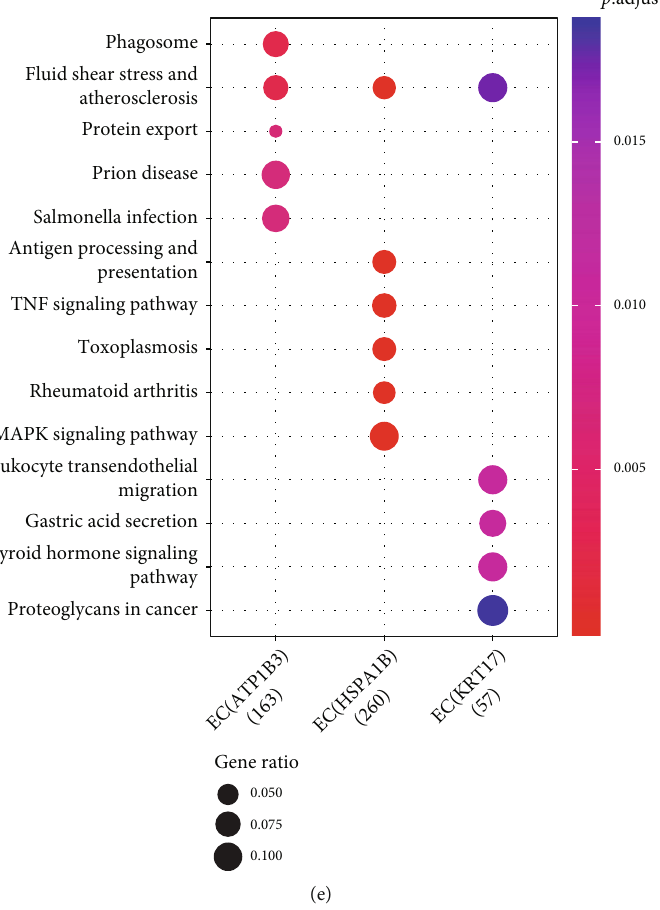
Figure 2: scRNA-seq analysis showed three subclusters in breast-associated biopsies. (a) UMAP plot showed integration of endothelial cells isolated from normal breast and TNBC tissues. Three subclusters were identi fi ed based on genetic pro fi les. (b) Violin plots showed the expression pattern of three feature genes ATP1B3 , HSPA1B , and KRT7. (c) Immuno fl uorescent staining of 3 endothelial cell subpopulations: EC (ATP1B3), EC (HSPA1B), and EC (KRT7). Endothelial cells were labelled with CD31. (d) Heatmap showed expression pattern of top 20 genes from each endothelial cell subclusters. (e) Dot plot revealed that each endothelial cell subcluster possesses distinct biological